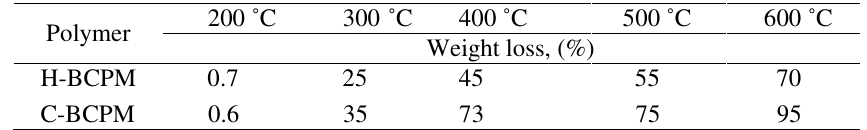
Table 6 . Percentage weight loss of homo and copolymer at various temperatures from the